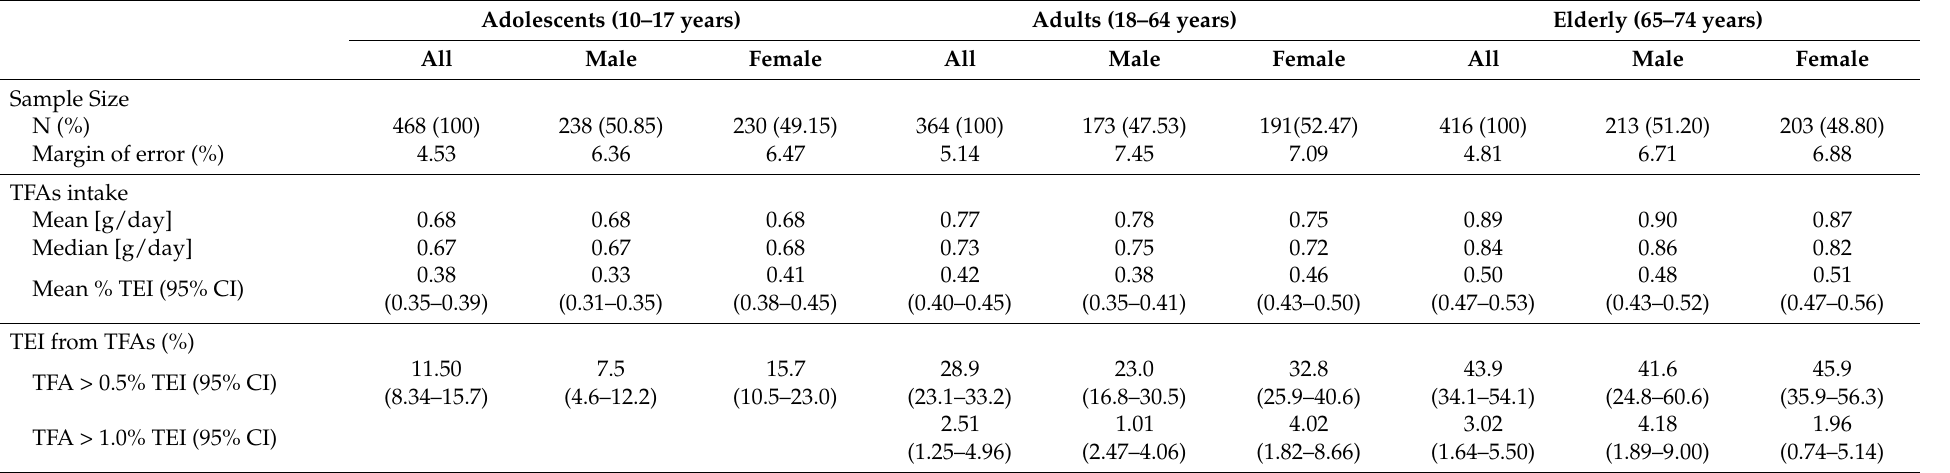
Table 1. Population-weighted trans fatty acid (TFA) intake (g/day) and prevalence of total energy intake (TEI) from TFAs > 0.5%/1.0% daily (95% CI), both cumulative and according to gender.